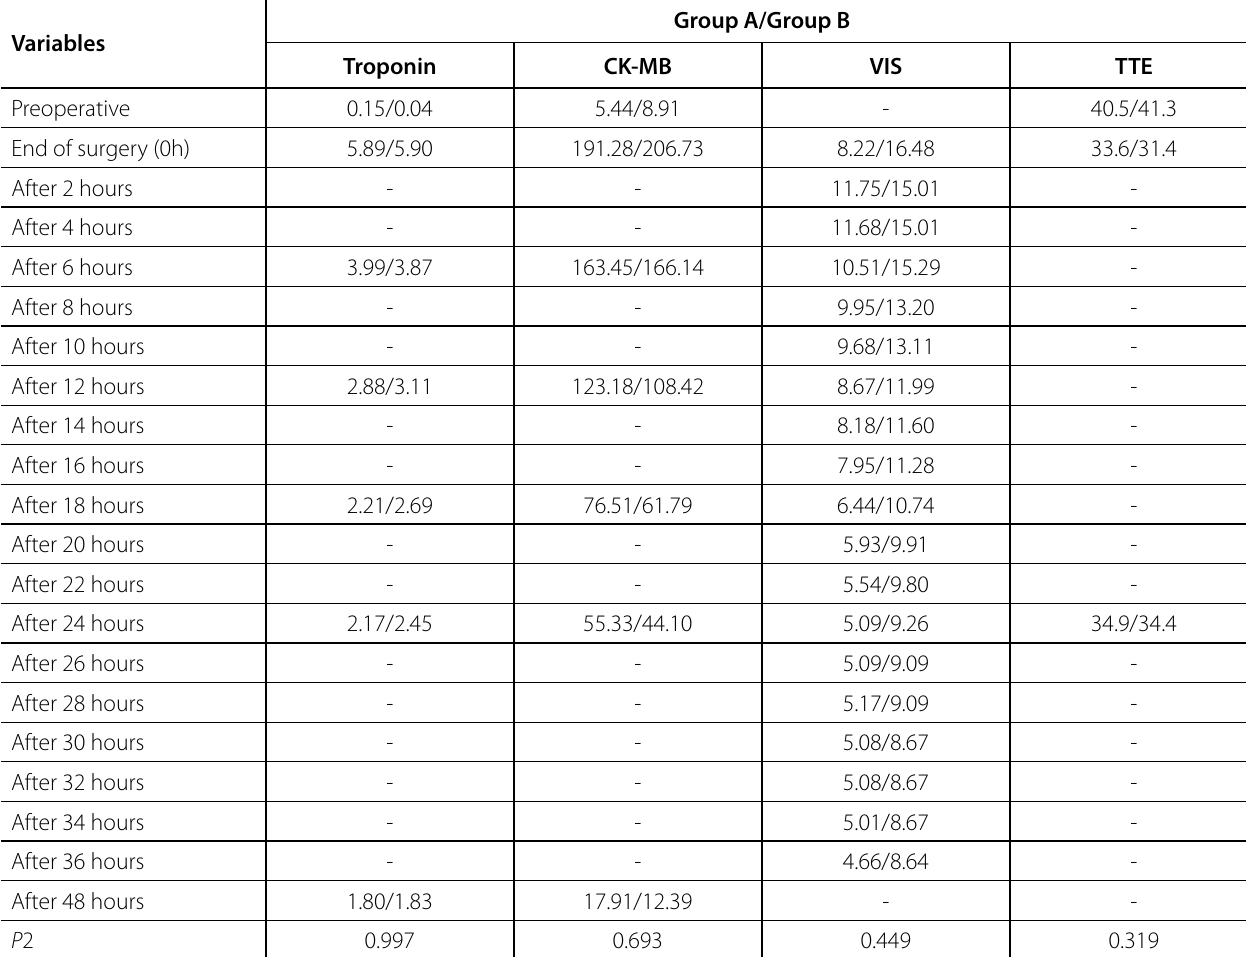
Table 4 . Values of the marginal means of troponin, CK-MB, VIS, and TTE between the groups at the different moments analyzed.